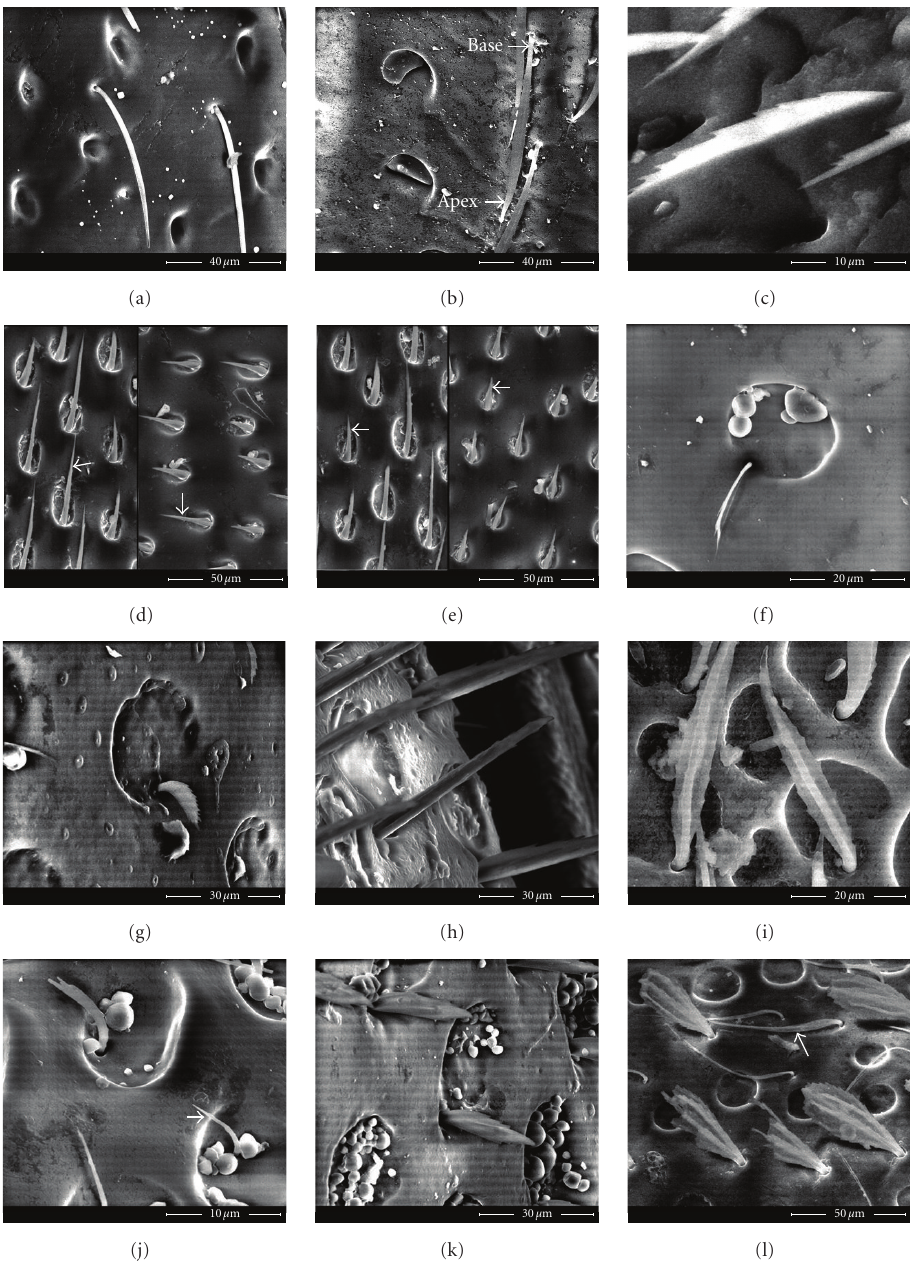
Figure 3: Hairs. (a) Lyctus africanus Lesne 1907, (b) Lyctus cinereus Blanchard 1851, (c) Trogoxylon impressum , (d) and (e) Cephalotoma perdepressa Lesne 1937 (left-lateral view, right-dorsal view), (f) Dinoderus ocellaris Stephens 1830, (g) Dinoderus punctatissimus Lesne 1897, (h) declivity of Dinoderus distinctus Lesne 1897, (i) Lyctus tomentosus Reitter 1879, (j) Dinoderus bifoveolatus (Wollaston 1858), (k) declivity of D. bifoveolatus , (l) Minthea reticulata Lesne